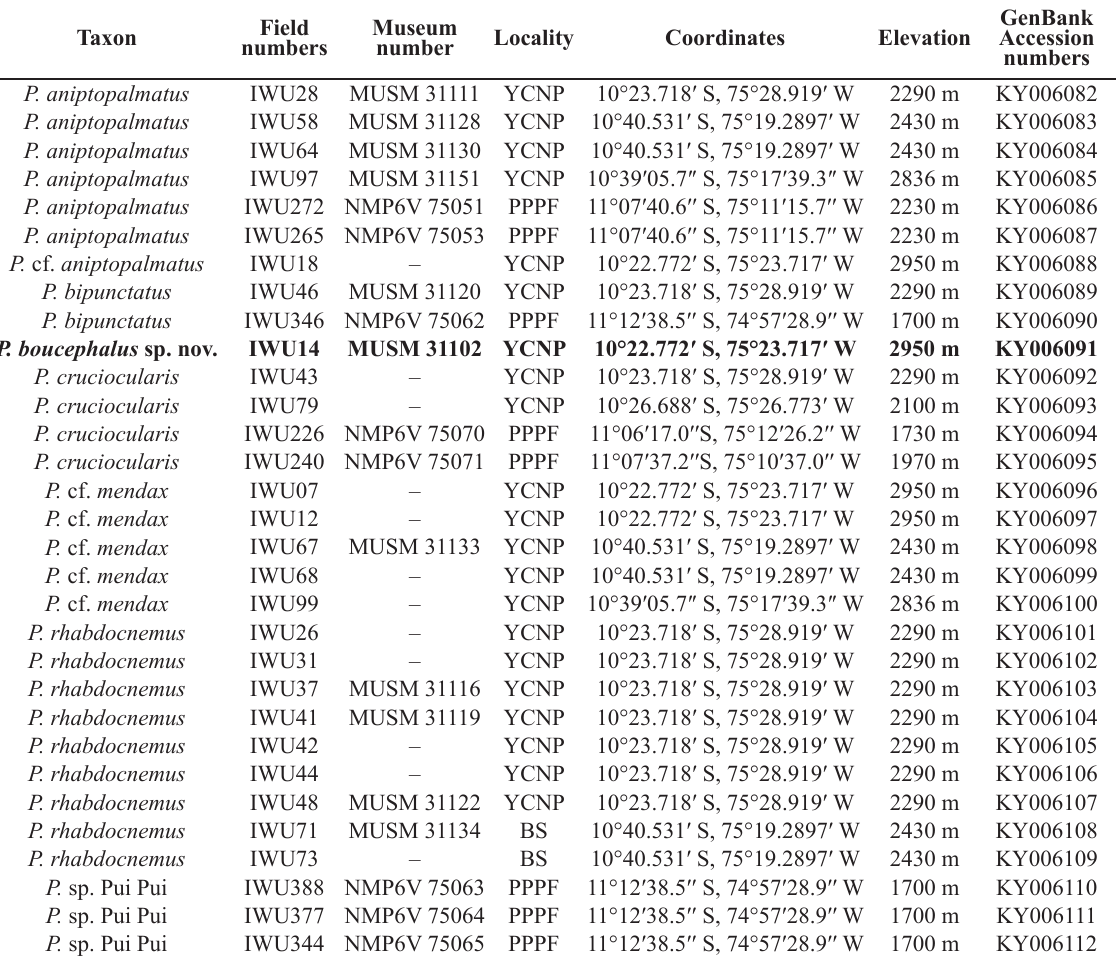
Table 1. Names of taxa, field numbers, museum numbers, field data, and GenBank accession numbers of newly genetically investigated material. The new species is indicated in bold. For abbreviations see